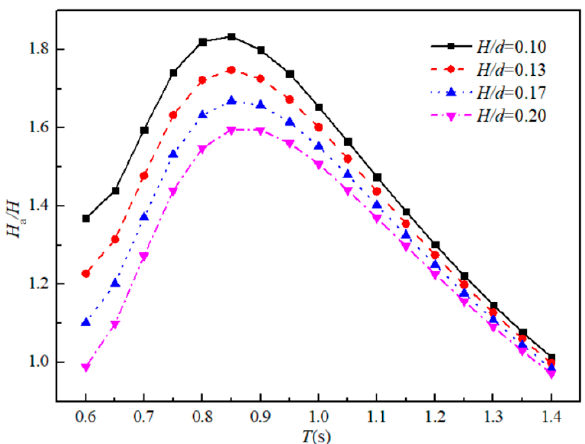
Figure 8. Variations of dimensionless water surface amplitude with different incident wave heights.